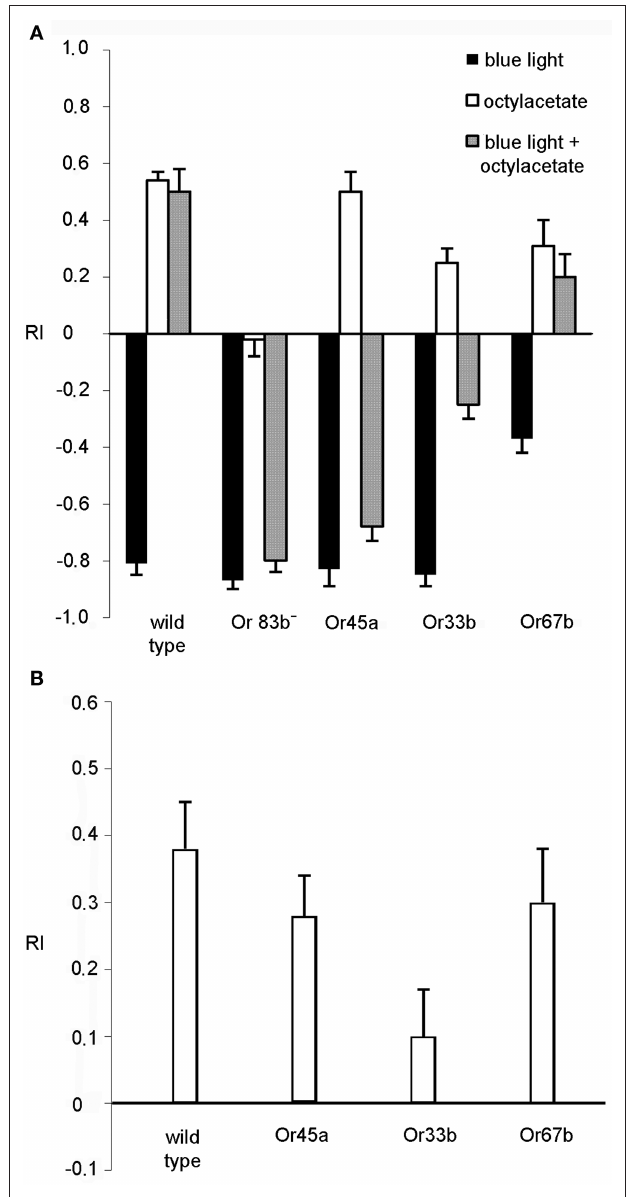
Figure 5 | Behavior in the presence of octyl acetate and blue light ( n = 10). (A) Reaction of wild type, anosmic (Or83b − ) and transgenic larvae that express Pac α under the control of the indicated driver lines. The repellent octyl acetate was presented on filter papers in the dark areas of the Petri dish. Stimulation was either with octyl acetate (white bars), with blue light (dark bars) or both together over a period of 30 s. (B) The larvae treated with odor and light simultaneously were tested for an additional 2 min in the presence of octyl acetate in the dark quadrants, but in complete darkness. Bars represent mean ±